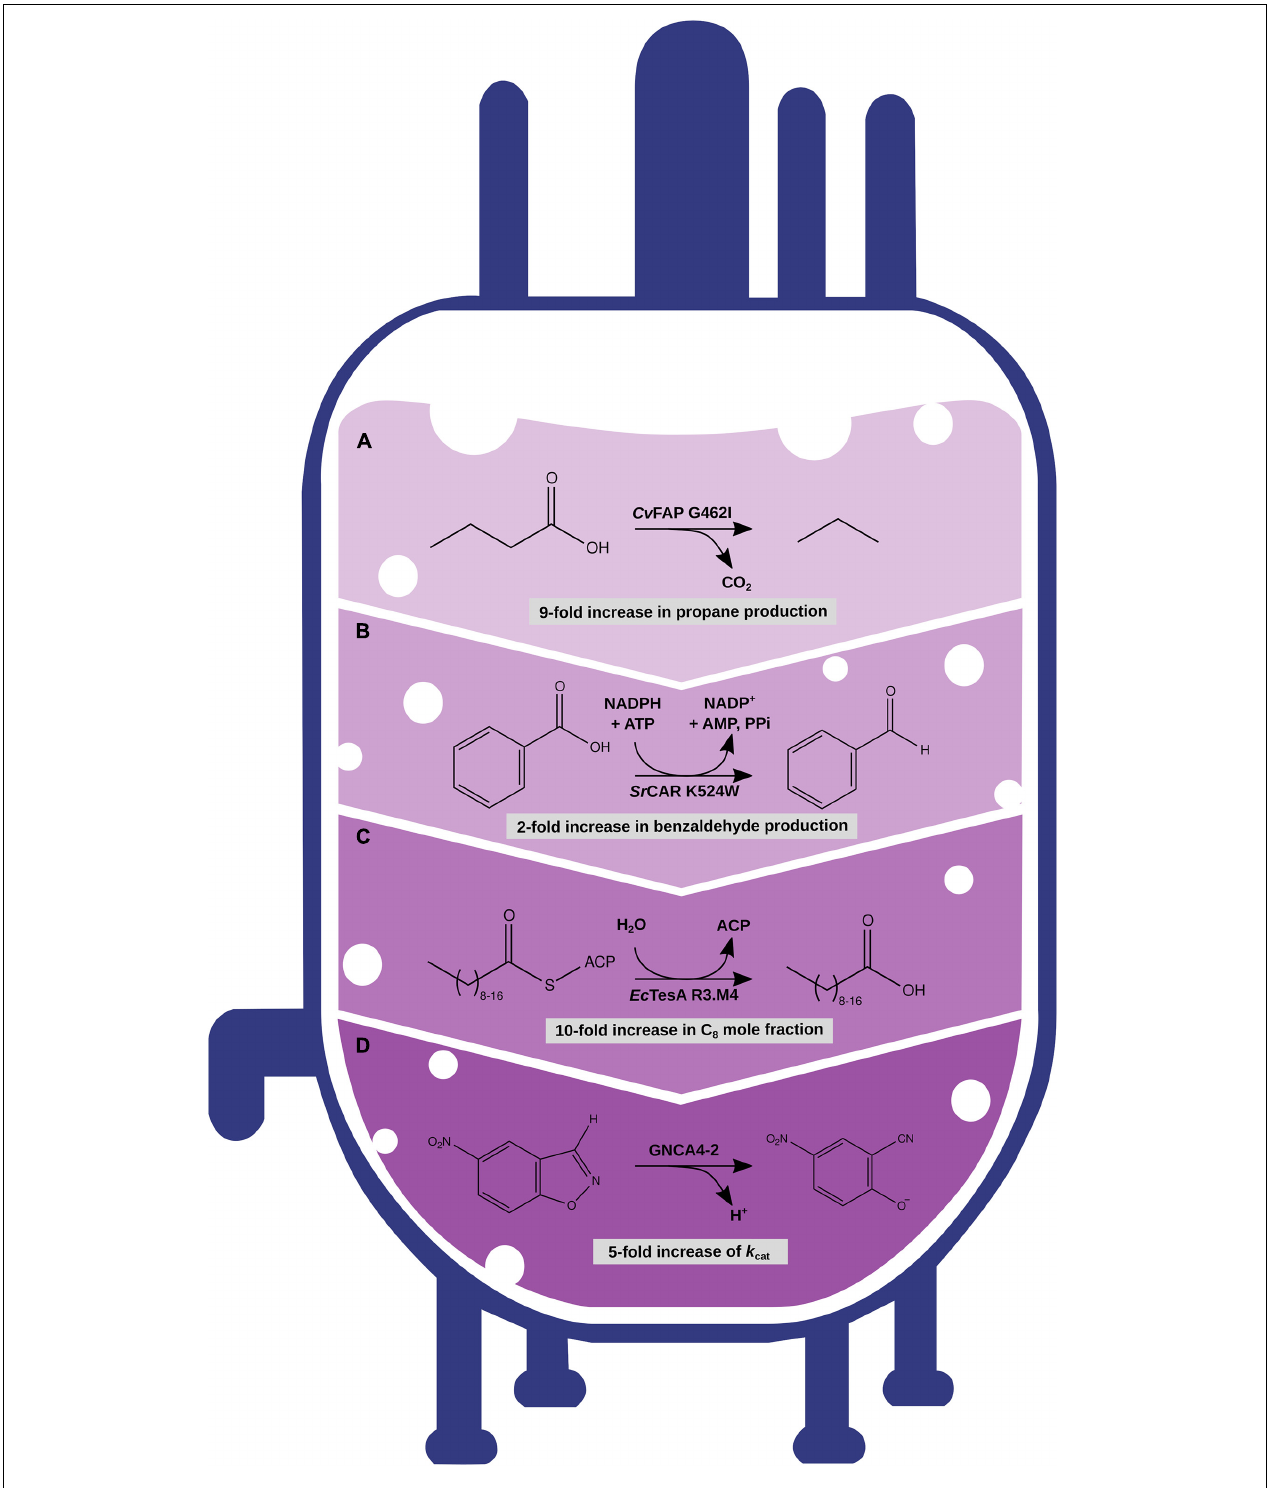
FIGURE 3 | Optimization of enzymes with different engineering strategies with increasing amount of computational modeling and predictions. (A) Rational engineering of CvFAP enzyme for the increased production of propane. (B) Rational engineering based on MD simulation data of SrCAR increased production of benzaldehyde. (C) Semirational sequence design with IPRO of EcTesA for altered substrate specificity. (D) Semirational sequence design with FuncLib and subsequent screening with the EVB approach to increase the catalytic efficiency of a Kemp eliminase GNCA4.